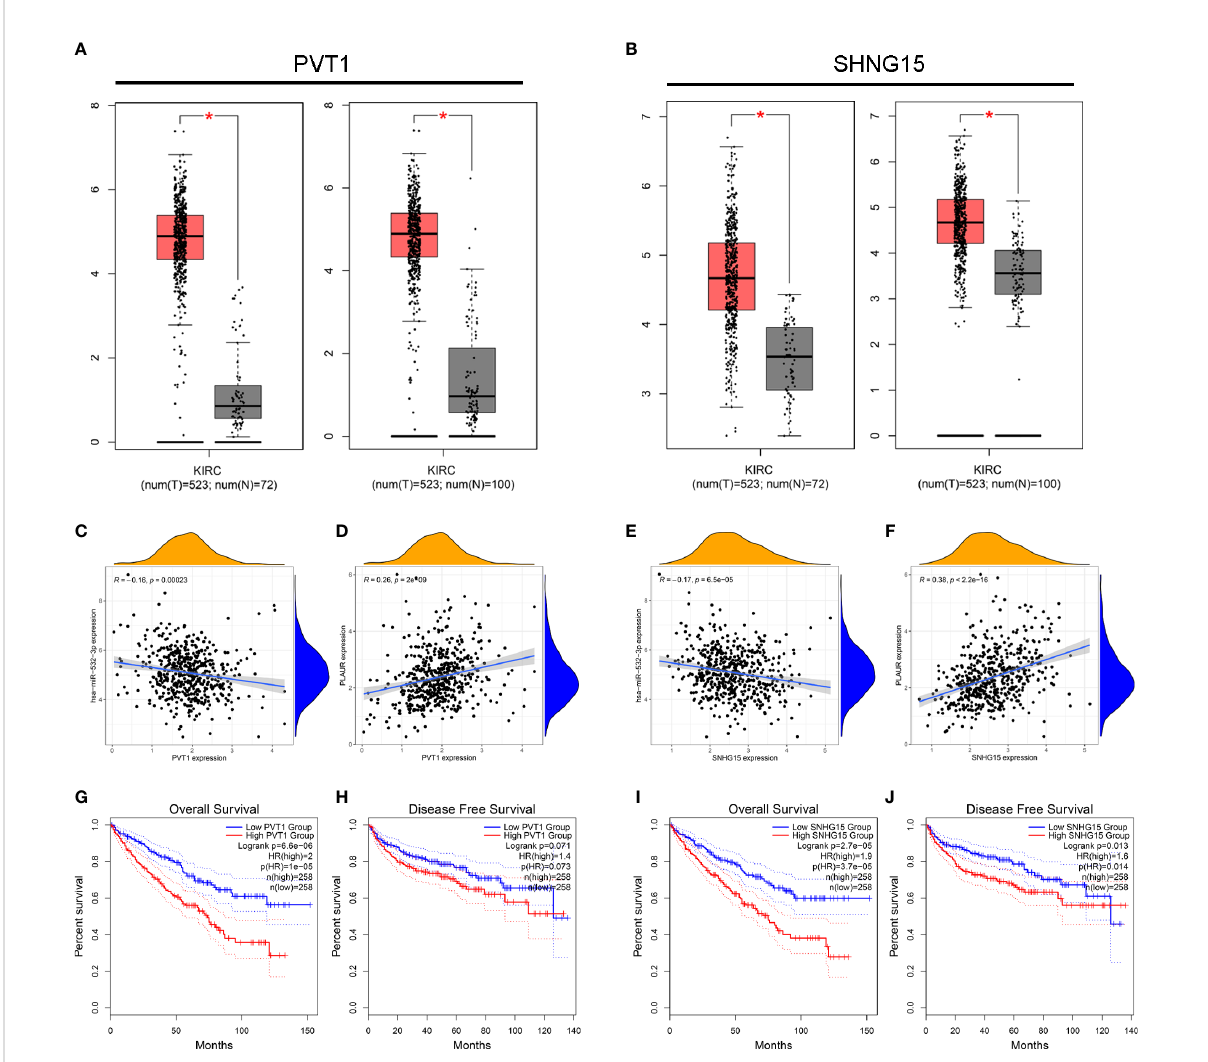
FIGURE 5 Identi fi cation of PVT1 and SNHG15 as two potential upstream lncRNAs of hsa-miR-532-3p-PLAUR axis in KIRC using the StarBase database. (A – B) The differential expression of PVT1 (A) and SNHG15 (B) in KIRC samples and “ TCGA normal ” or “ TCGA and GTEx normal ” samples. (C-D) The expression correlation between PVT1 and hsa-miR-532-3p (C) , PVT1 and PLAUR (D) in KIRC. (E – F) The expression correlation between SNHG15 and hsa-miR-532- 3p (E) , SNHG15 and PLAUR (F) in KIRC. (G – H) Kaplan-Meier survival curve of OS for PVT1 (G) and SNHG15 (H) . (I – J) Kaplan-Meier survival curve of DFS for PVT1 (G) and SNHG15 (H)